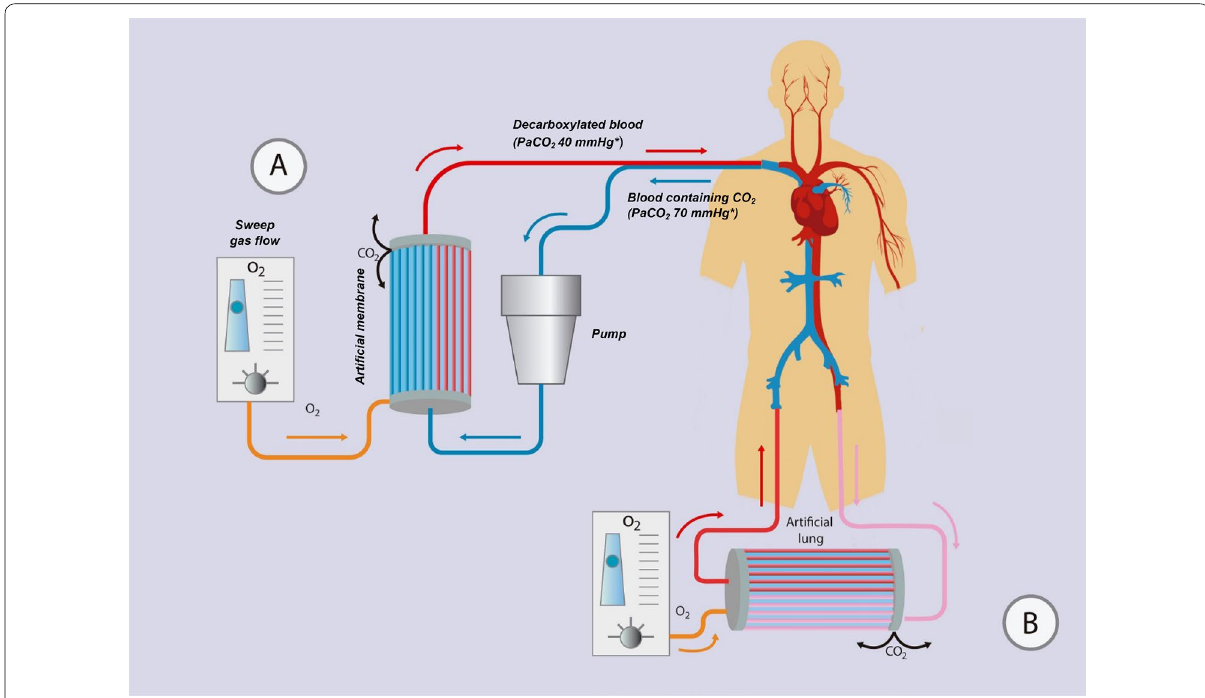
Fig. 1 ECCO 2 R common configurations. a Minimally invasive veno‑venous ECCO 2 R system with a single venous vascular access through a double‑lumen cannula that can be inserted in the internal jugular or femoral vein. b Pumpless arterio‑venous ECCO 2 R system with the placement of the membrane in the circuit connecting the femoral artery with the contralateral vein. *PaCO 2 values are purely